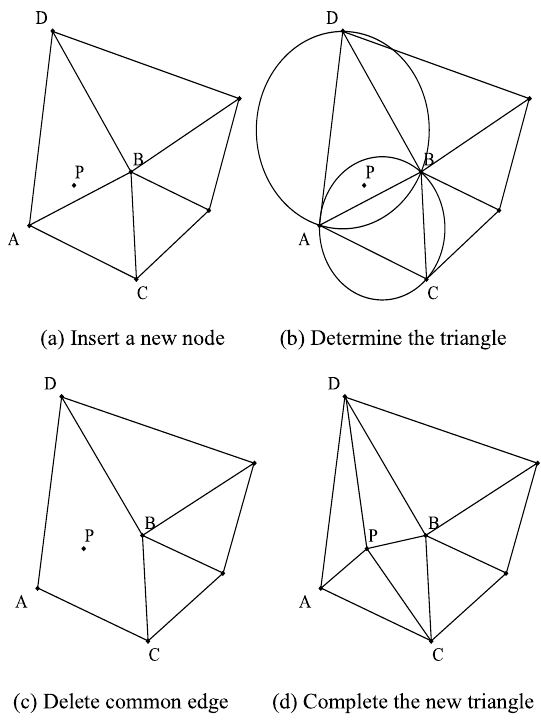
Figure 6. Steps to insert a point to construct a triangle